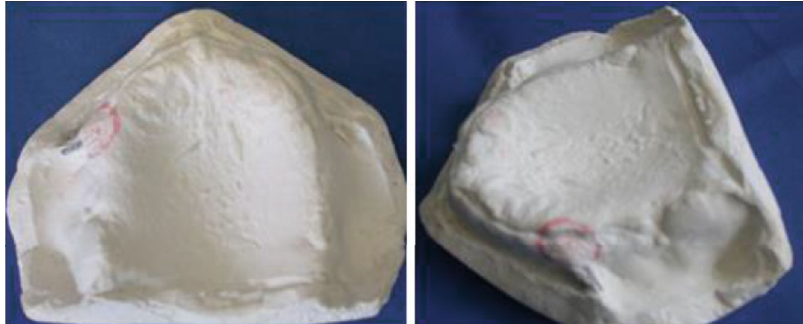
Figure 25: Lateral frenulum scribed on the preliminary cast.